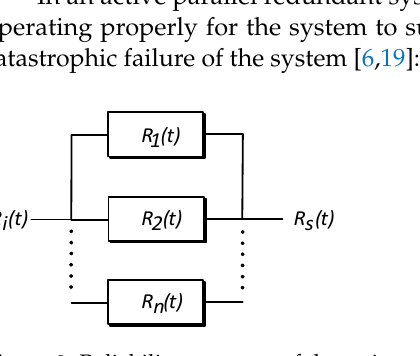
Figure 2. Reliability structure of the active parallel redundant system.